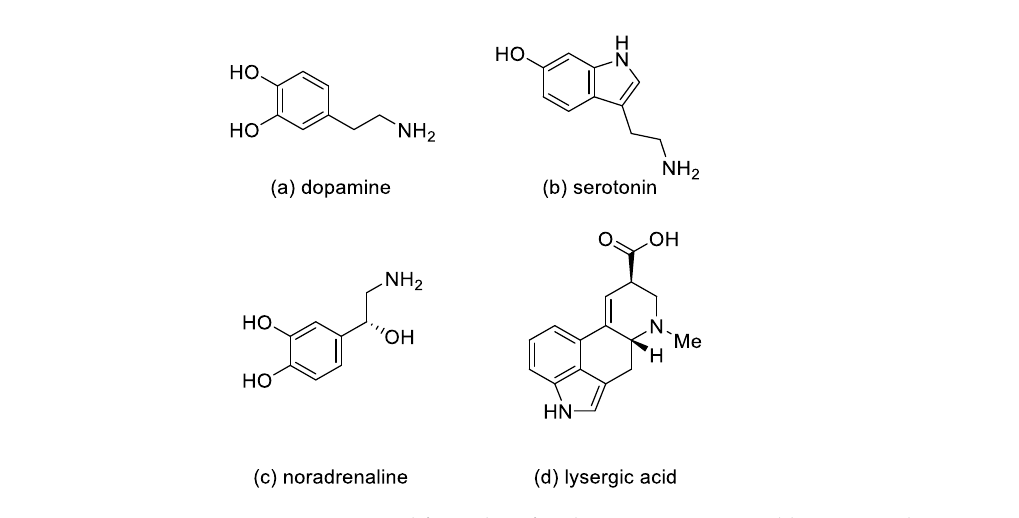
Figure 3. Structural formulas of endogenous amines and lysergic acid.